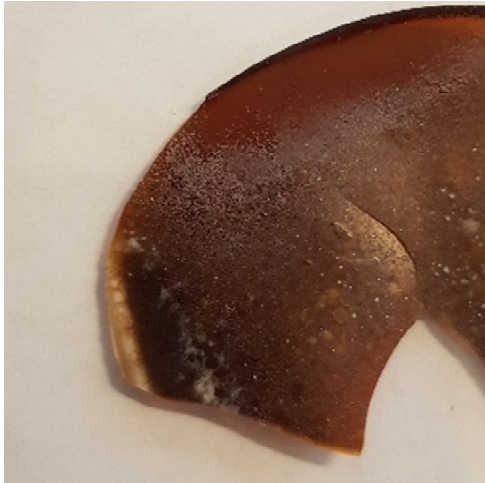
Figure 8. Film of pure CN obtained through casting. Table 2. Extracted fraction in water.